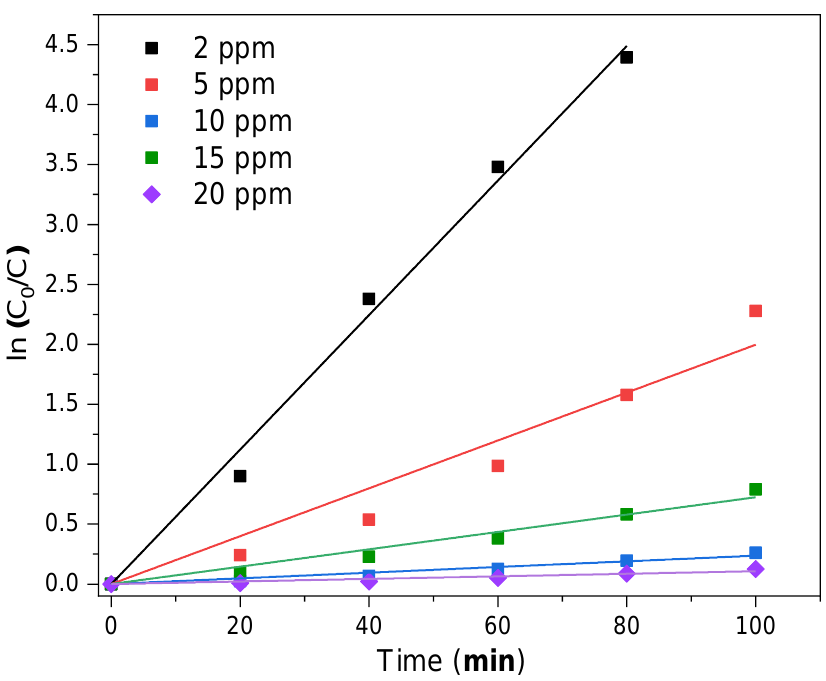
Figure 8. Pseudo-first-order kinetics for BPB at different initial concentration with 100 mg/L of catalyst under UV irradiation. Table 3. Variation of the pseudo-first-order rate constant ( k 1 ) at various initial concentration of BPB ( C 0 ).